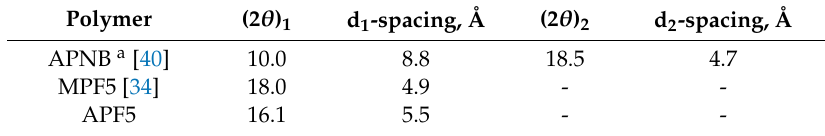
Table 4. The results of WAXD study of some addition and metathesis polynorbornenes. Polymer